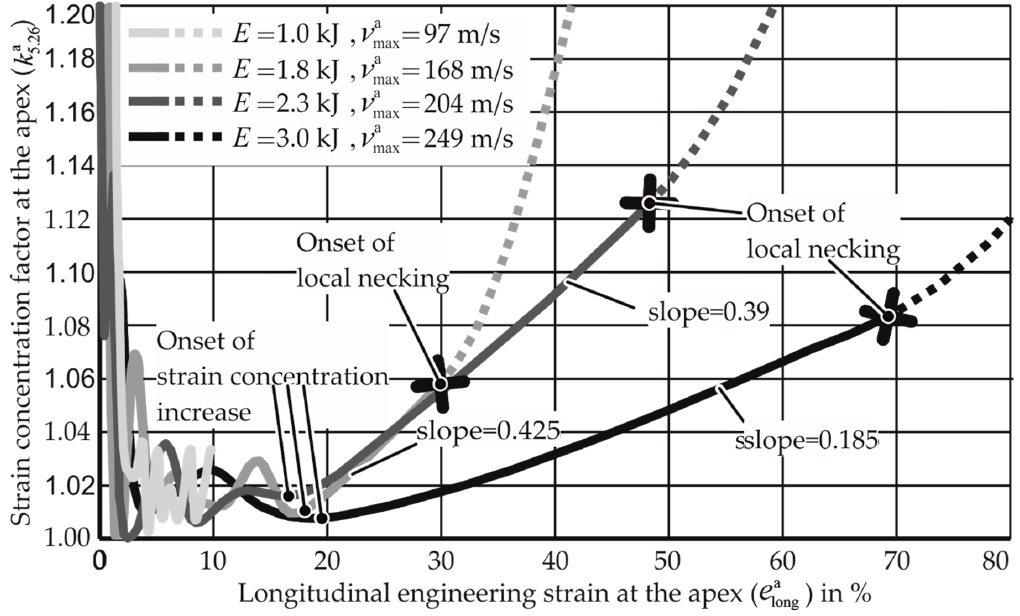
Figure 23. Simulations of the electromagnetic forming limit test with AW-5083-H111 under uniaxial tension. E denotes the input energy of the simulated experiment. v a max denotes the maximum apex velocity in the simulation.